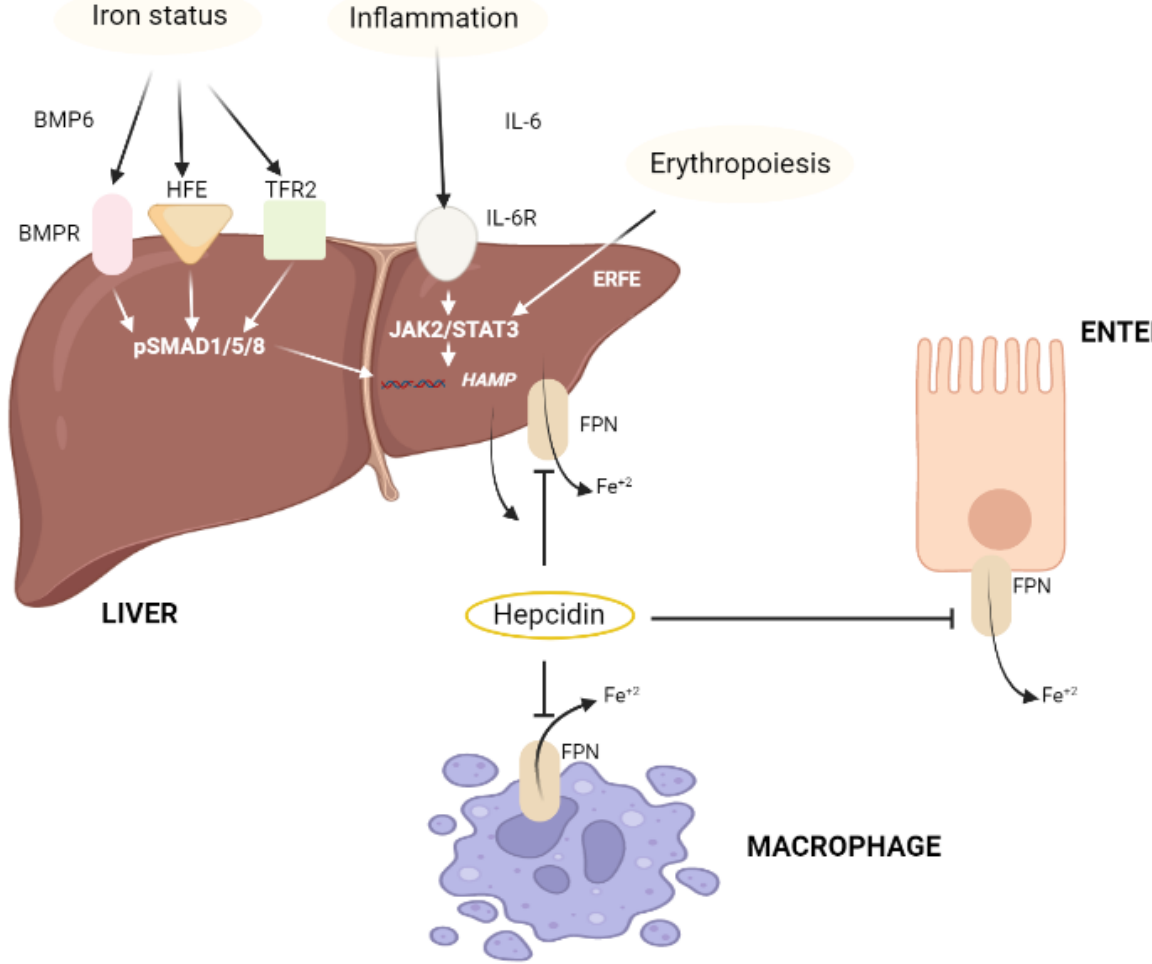
Figure 3. The mechanism of action and expression of hepcidin.